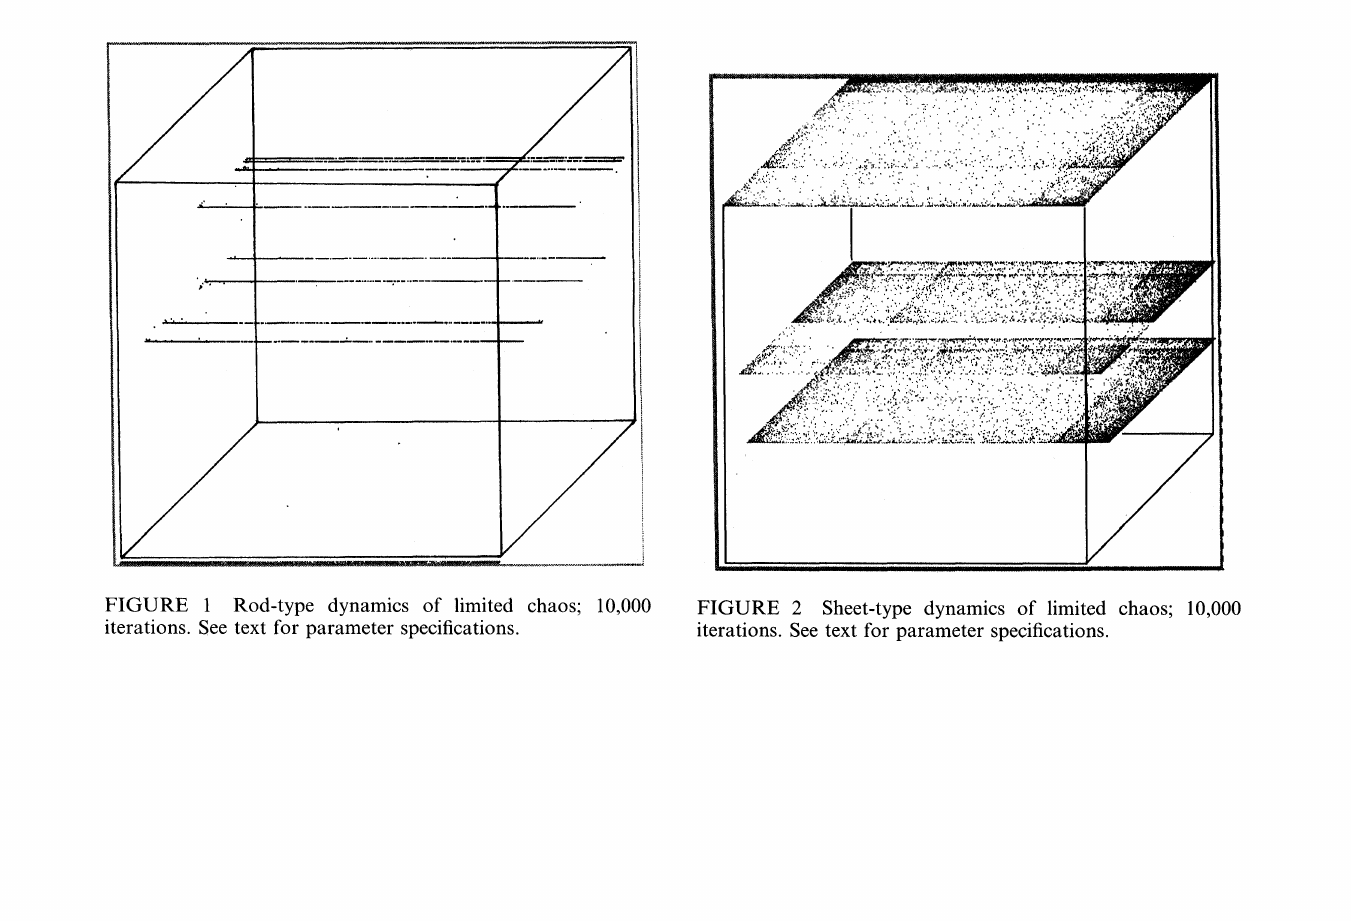
Rod-type dynamics of limited chaos; 10,000 iterations. See text for parameter specifications.